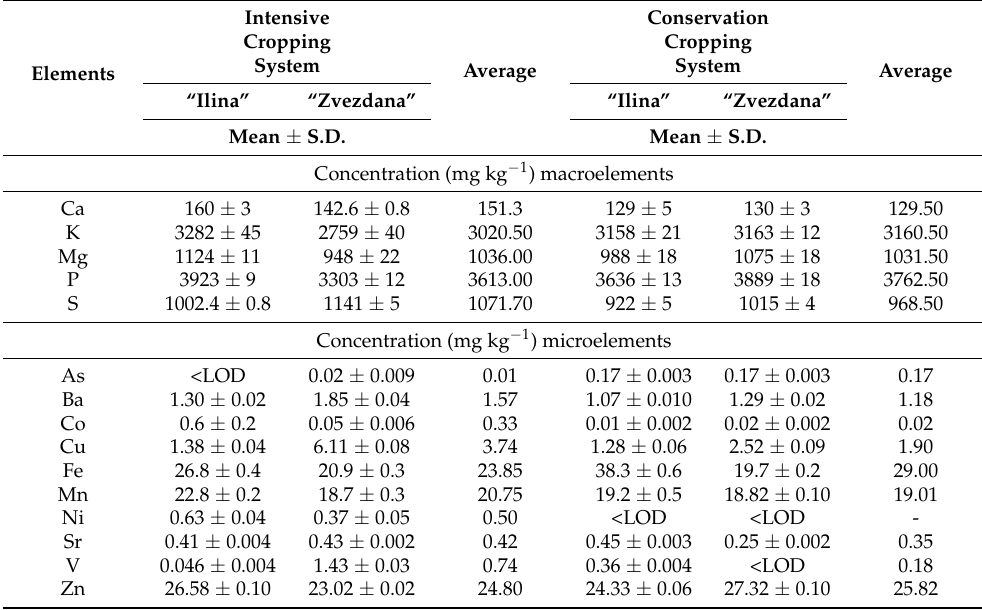
Table 2. Mean concentration of the macro- and microelements in the wheat grain in ICS and CCS cropping